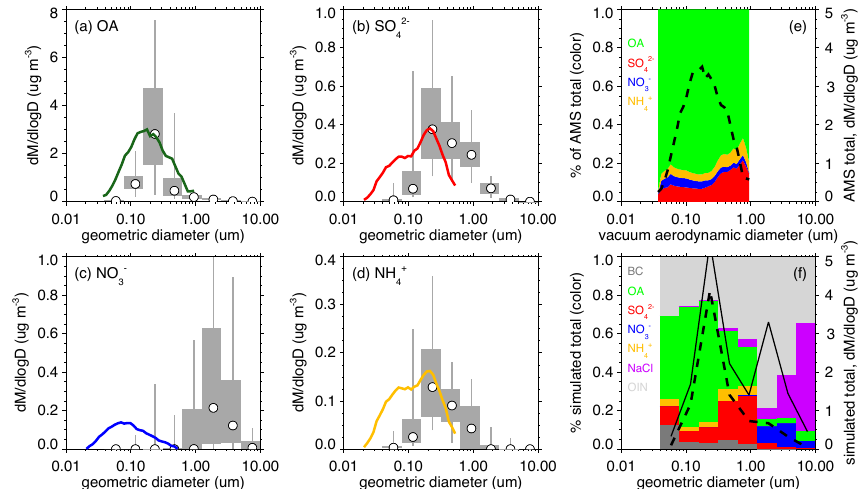
Figure 22. Observed size distribution of (a) OA, (b) SO 2 − percentiles for each size bin from the 50%_LBC simulation (gray). Vertical lines denote 5th and 95th percentiles, boxes denote 25th and 75th percentiles, and the white dots denote the 50th percentiles. (e) and (f) depict % of total mass by composition as well as total mass. Dashed lines in (e) and (f) are for the total of OA, SO 2 − model.